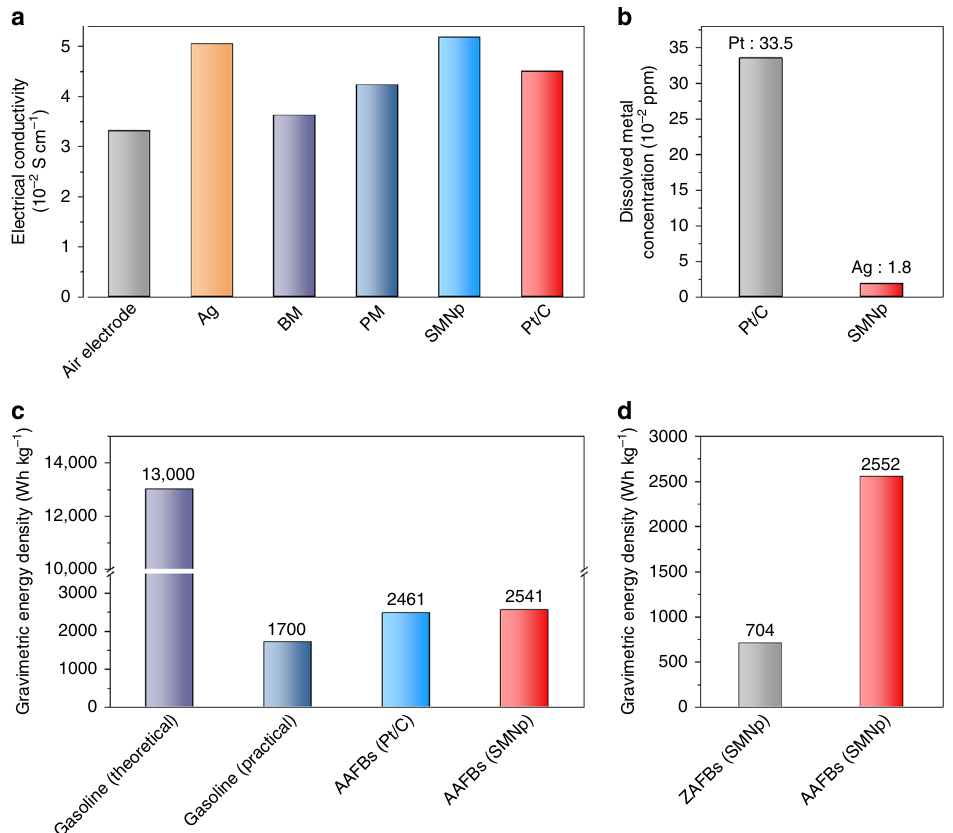
Fig. 5 Comparison of electrode properties and battery performance. a Electrical conductivity of the Ag nanoparticle, bulk manganese oxides (BM), polyhedron manganese oxide (PM), silver manganate nanoplate (SMNp), and Pt/C-loaded air electrodes. b Precious metal dissolution tests in aluminum – air fl ow batteries (AAFBs) using the SMNp and Pt/C with 6 M KOH electrolyte after 6 h of discharging at 50 mA cm − 2 . c , d Comparison of the gravimetric energy density ( c ) among gasoline with theoretical and practical value, AAFBs with Pt/C and SMNp (at 50 mA cm − 2 ), and comparison of the gravimetric energy density ( d ) between zinc – air fl ow batteries (ZAFBs) and AAFBs with the SMNp at 100 mA cm −